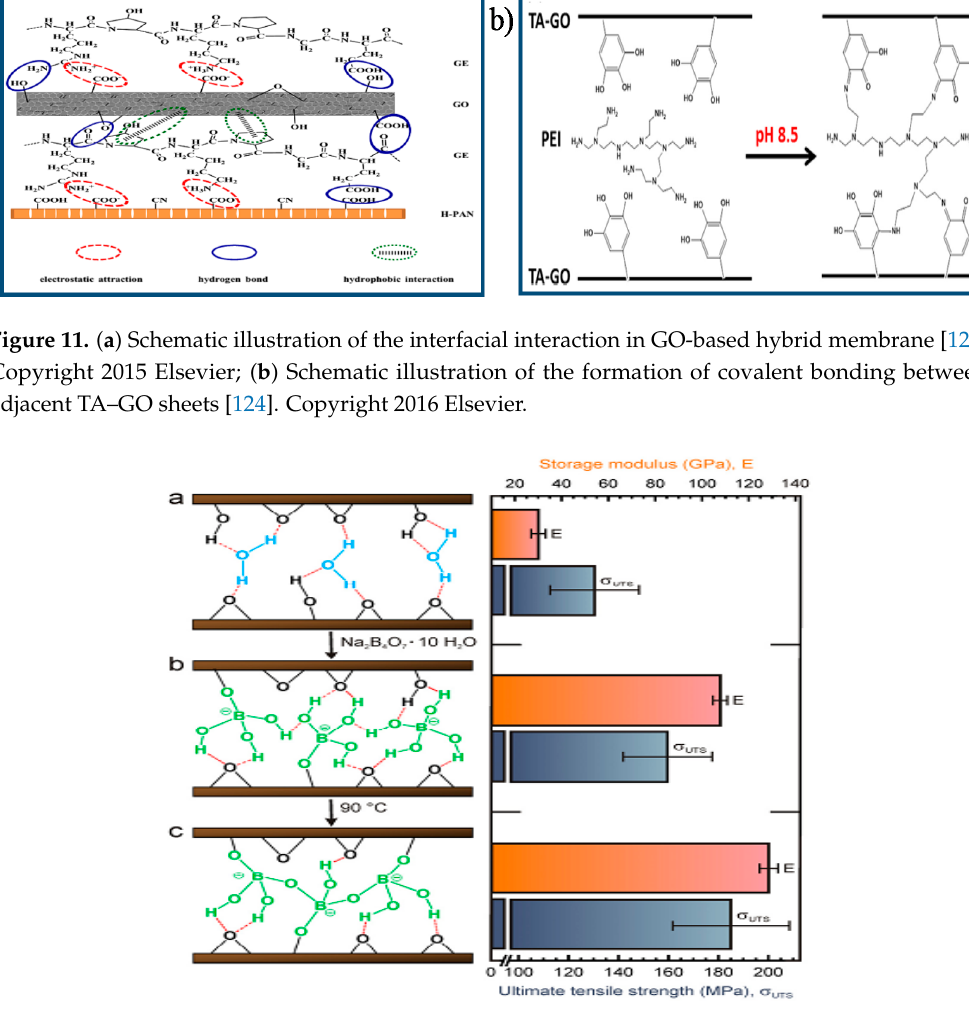
Figure 12. Left: Schematic diagram of the formation of covalent bonding between GO sheets and borate ion. ( a ) Water molecules bound the GO sheets through hydrogen bond; ( b ) Borate anions bound to the GO sheets through covalent bond; ( c ) More covalent bonds formed within the GO sheets after thermal annealing. Right: Mechanical strength of respective films [49]. Copyright 2011 John Wiely and Sons.